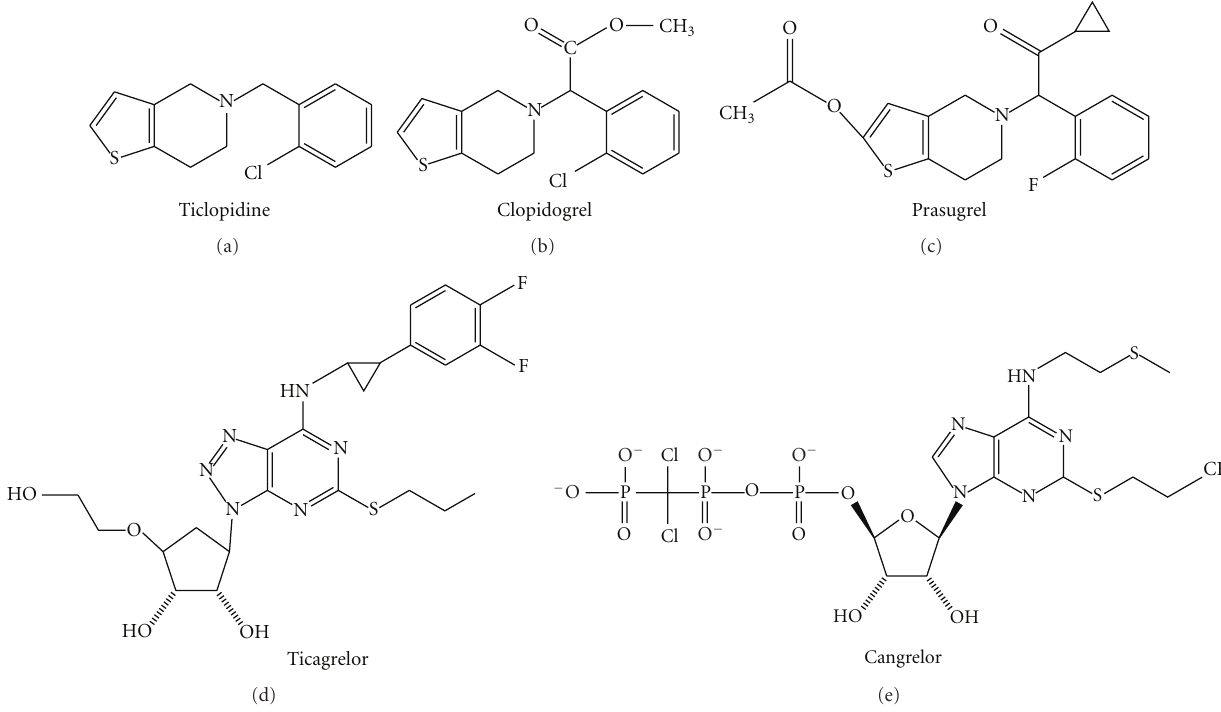
Figure 1: Biochemical structures of thienopyridine and nonthienopirydine antiplatelet agents.